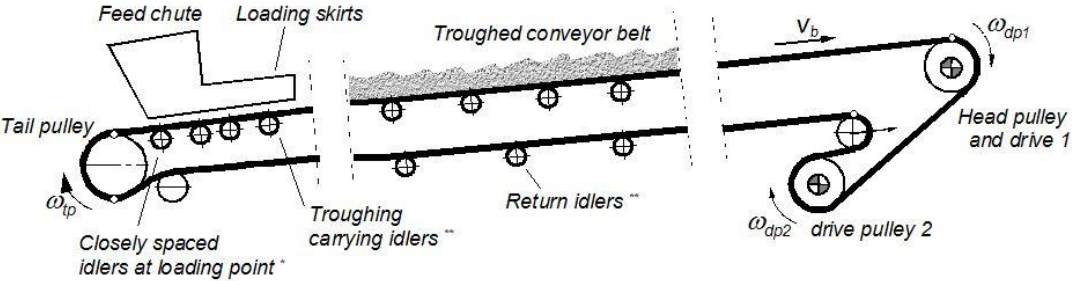
Figure 2. Layout of the main conveyor objects [18].